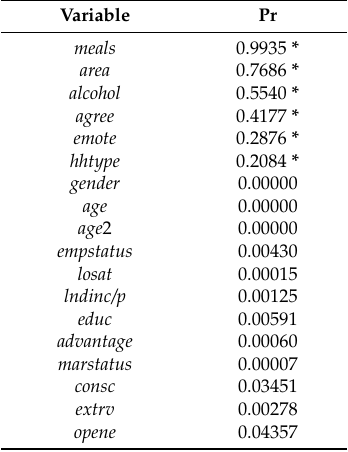
Table A1. Sequential parameter restriction test.